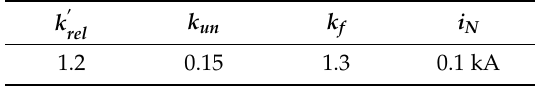
Figure 15. Transient current waveforms of s 2 and s 3 . ( a ) Pole-to-pole faults caused by f 1 ; ( b ) pole-to- ground faults caused by f 1 ; ( c ) pole-to-pole faults caused by f 2 ; ( d ) pole-to-ground faults caused by f 2 .